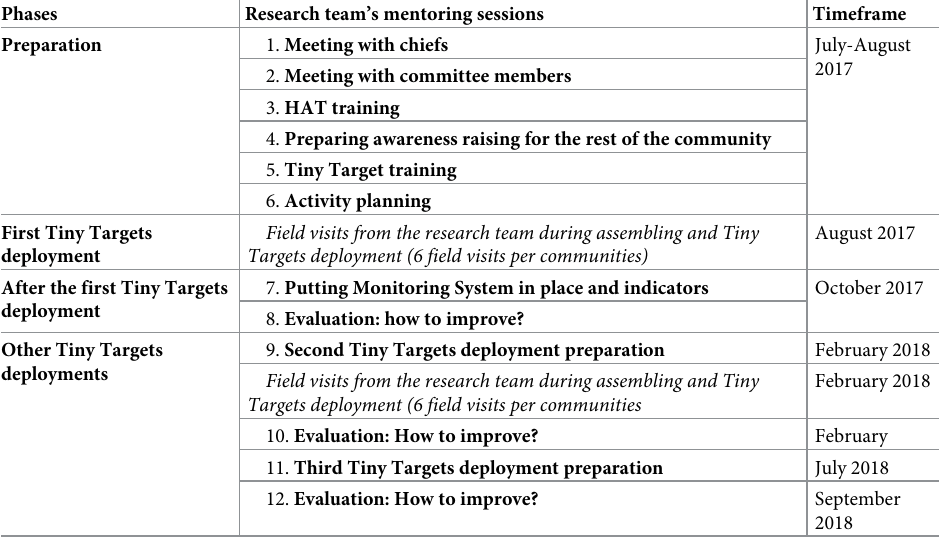
Table 1. List of all field activities that benefited from face-to-face support by the research